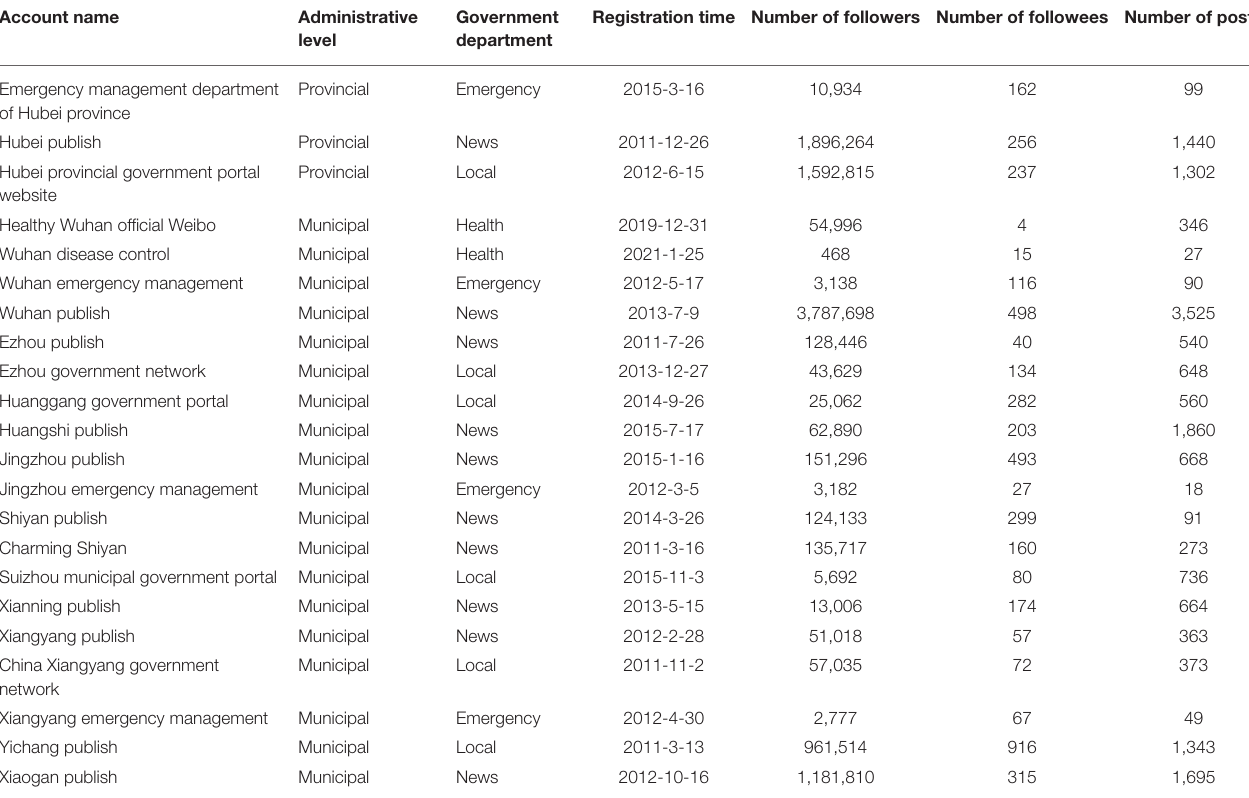
TABLE 2 | Basic information of the GSM